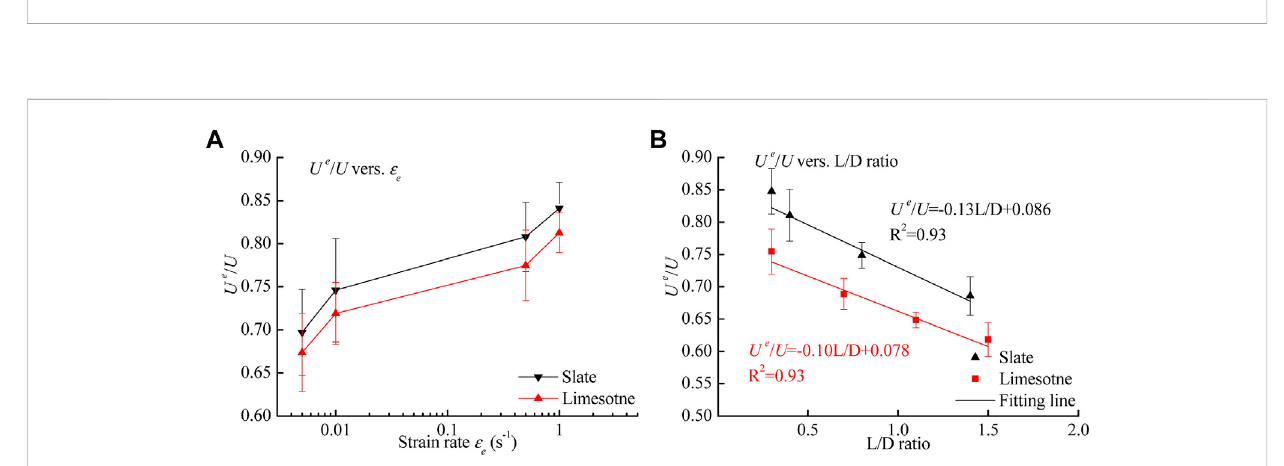
FIGURE 7 Relationship between (A) U e and U d versus U and (B) U d p versus U d for limestone and slate.